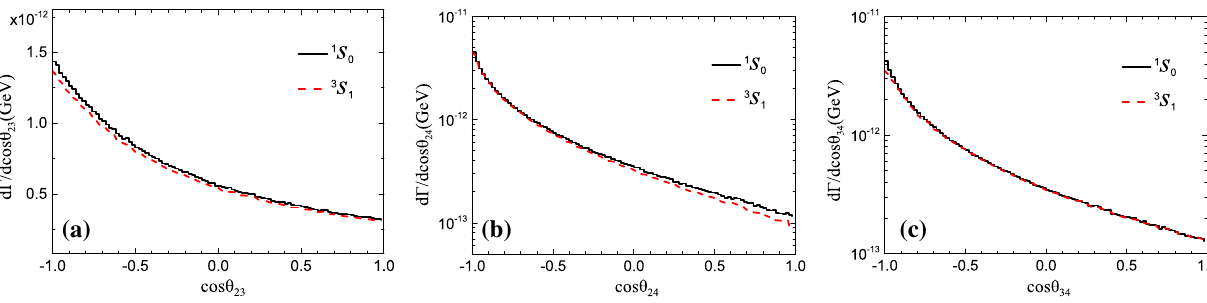
Fig. 8 The differential decay width not via FCNC d (cid:2)/ d cos θ 23 ( a ), d (cid:2)/ d cos θ 24 ( b ) and d (cid:2)/ d cos θ 34 ( c ) for t → | ( c ¯ b ) [ n ](cid:5) + b + Z 0